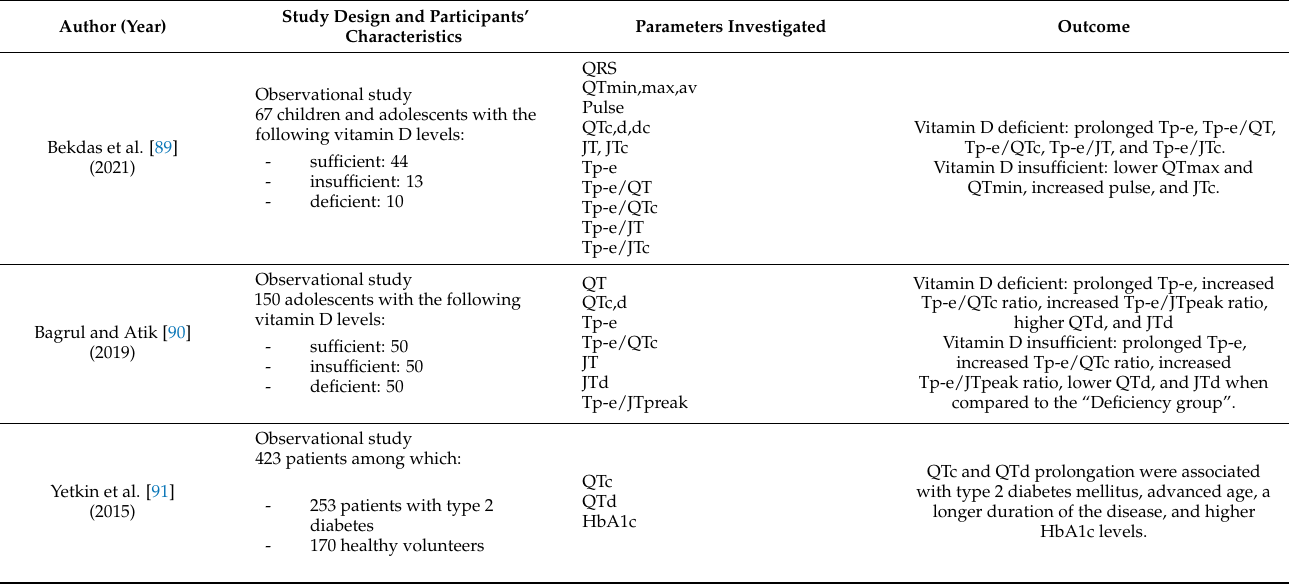
Table 2. The relationship between vitamin D levels and ventricular